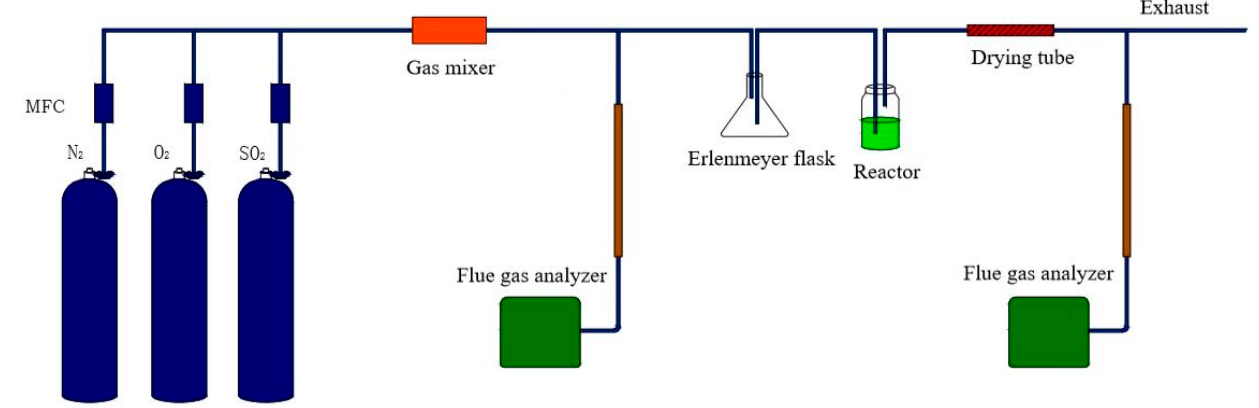
Figure 9. Schematic diagram of the experimental apparatus.